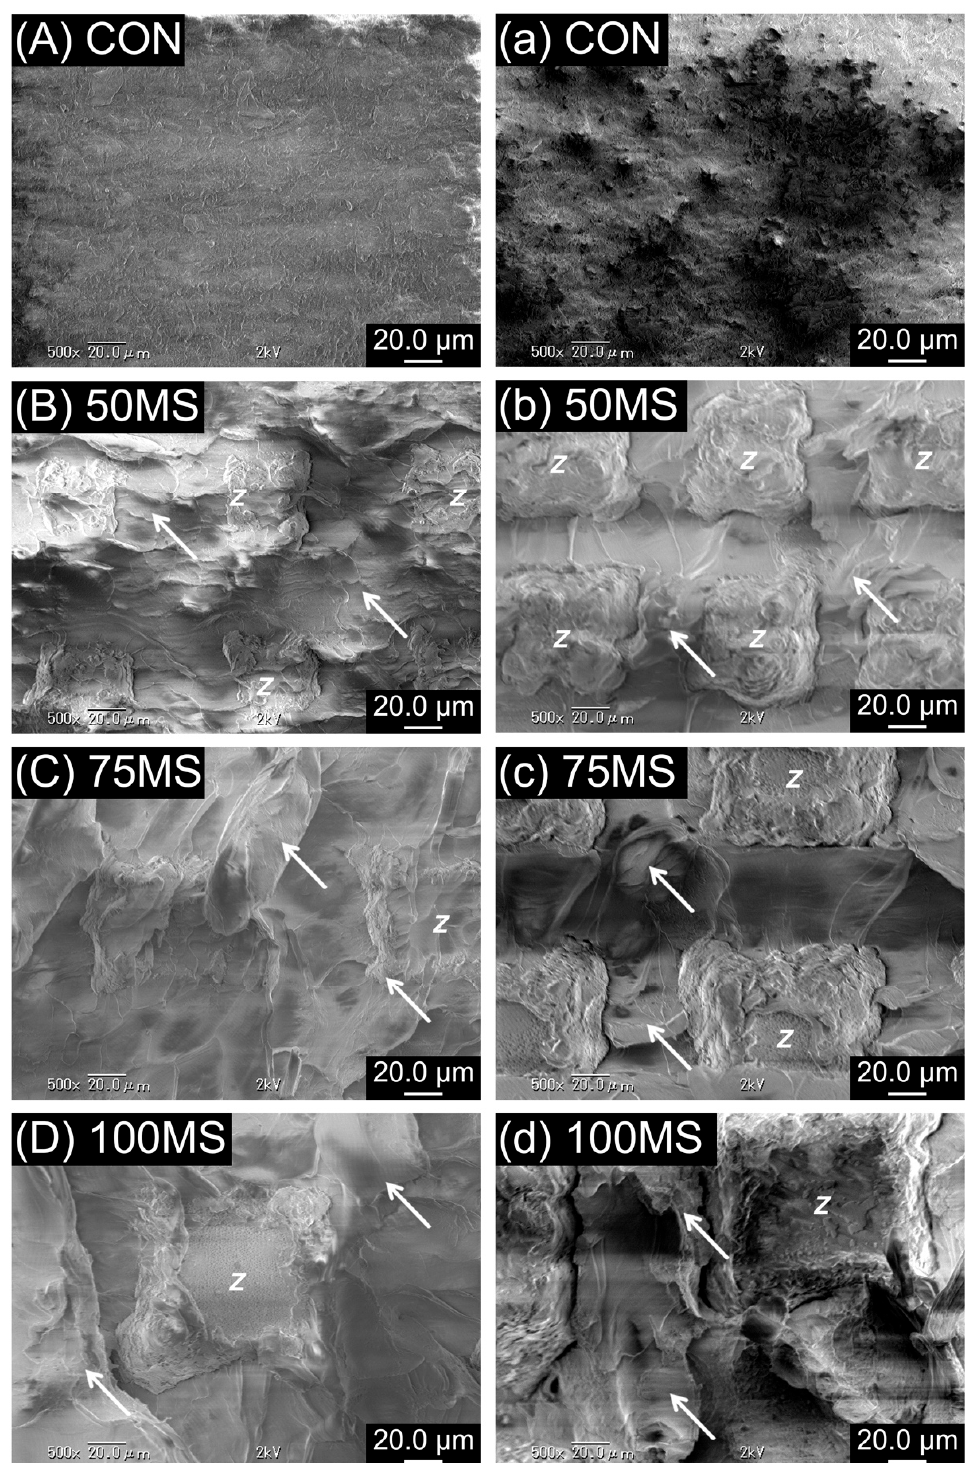
Figure 4. Scanning electron micrographs (SEM) of debonded Y-TZP and acrylic resin interface before ( A – D ) and after artificial aging ( a – d ). The arrow in the figure refers to the residual acrylic resins, while the Latin script letter Z refers to zirconia ceramics; original magnification 500×.